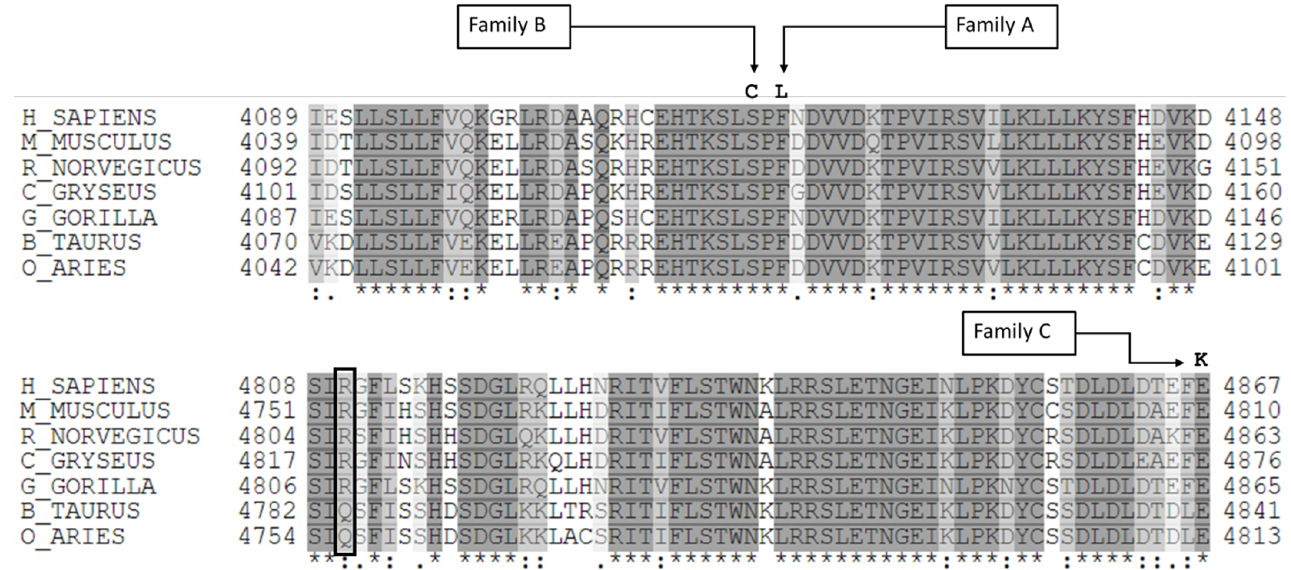
Figure 5. Alignment of RNF213 protein from different species. Amino acid changes identified in our patients all affected highly conserved residues among species ( Homo sapiens , Mus musculus , Rattus norvegicus , Cricetulus griceus , Gorilla gorilla , Bos taurus , and Ovis aries ). A box indicates the position of Arg 4810 , the canonical polymorphic variant in East Asian populations; (*) positions with a single, fully conserved residue; (:) positions with conservation between amino acids with similar properties; (.) positions with conservation between amino acids of weakly similar properties.